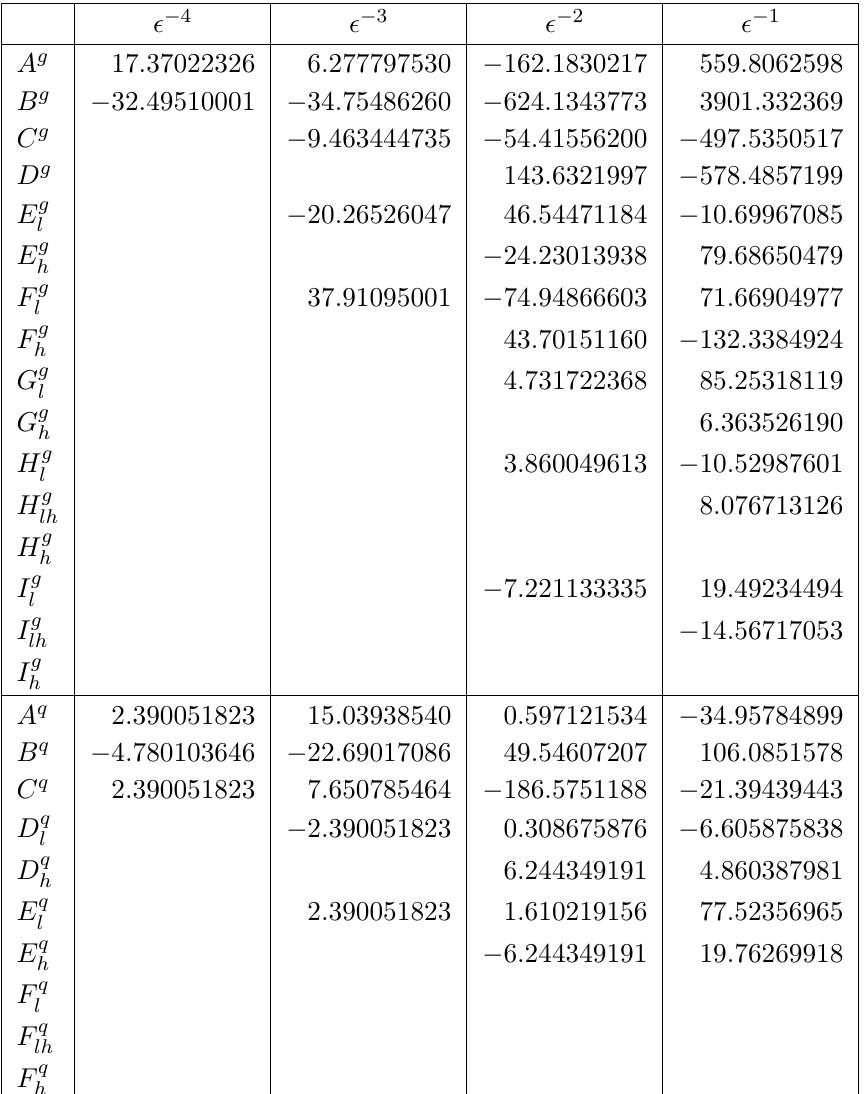
Table 1 . IR poles decomposed as color coefficients for the phase-space point x 12 = 10 , x 13